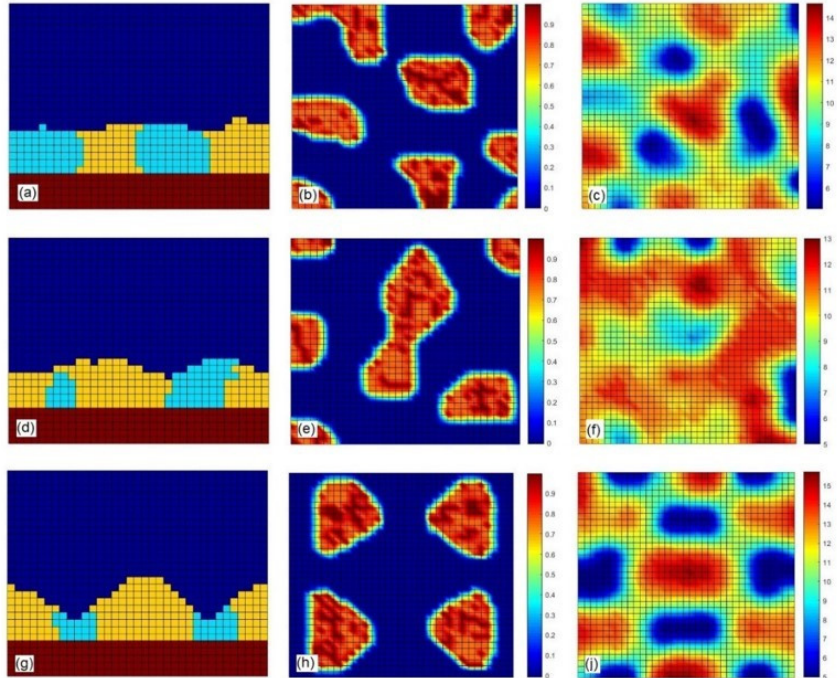
Figure 10. Cross-sectional views ( a , d , g ), concentration plots of component A (in the surface layer of thin films) ( b , e , h ), and surface maps ( c , f , i ) calculated at the substrate temperatures of 200 °C ( a – c ), 350 °C ( d – f ), and 650 °C ( g – i ).